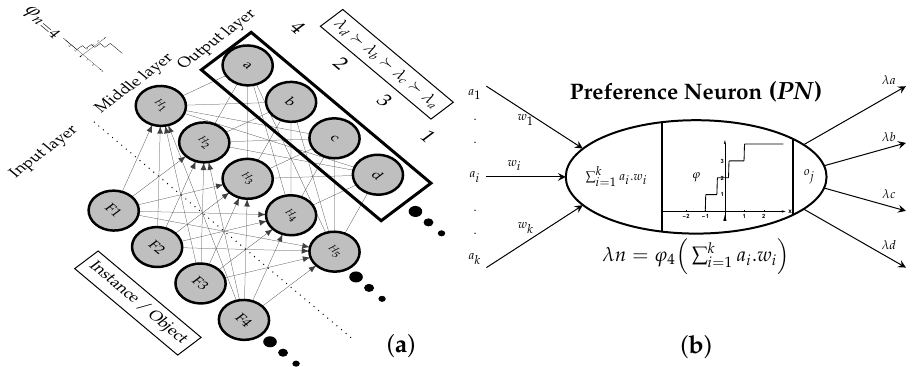
Figure 5. Architecture of Preference Neural Network and Neuron ( a ) Preference Neural Network ( b ) Preference Neuron ( PN ) where ϕ n = 4 , f in =